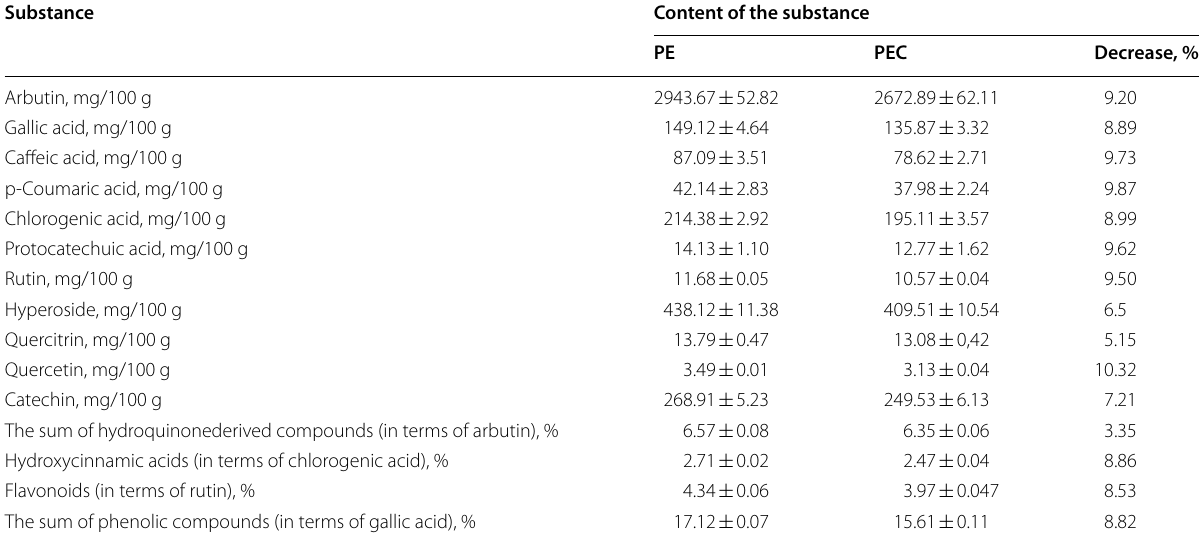
Table 1 The results of HPLC and spectrophotometry analysis of the dry bearberry leaves extracts